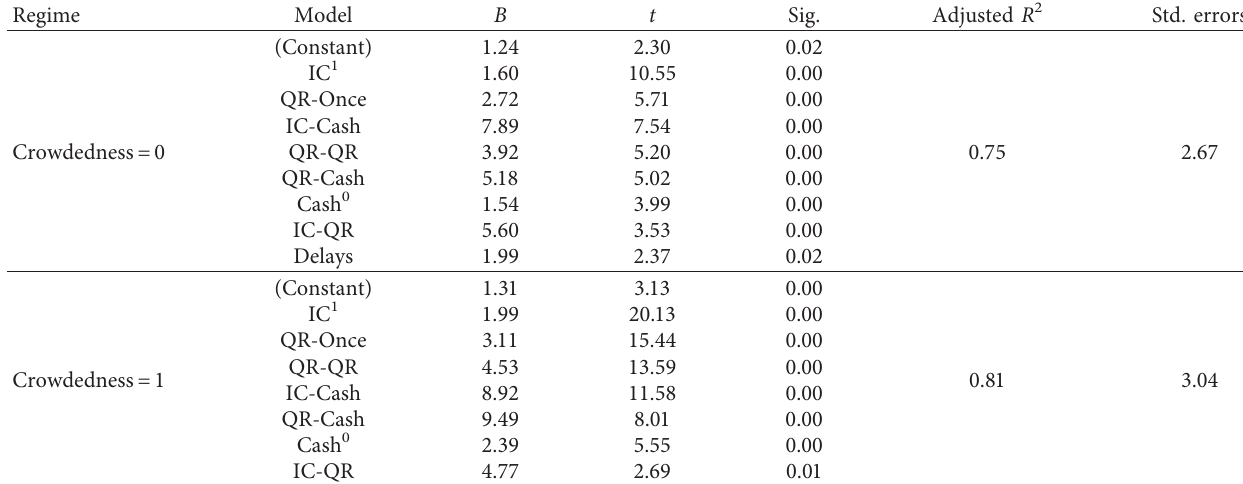
Table 4: Choice-transfer-based BST regression analysis.